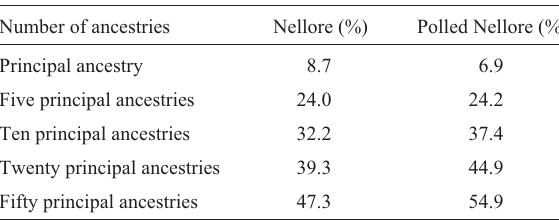
Table 2 - Genetic contribution of the principal ancestries in each strain.